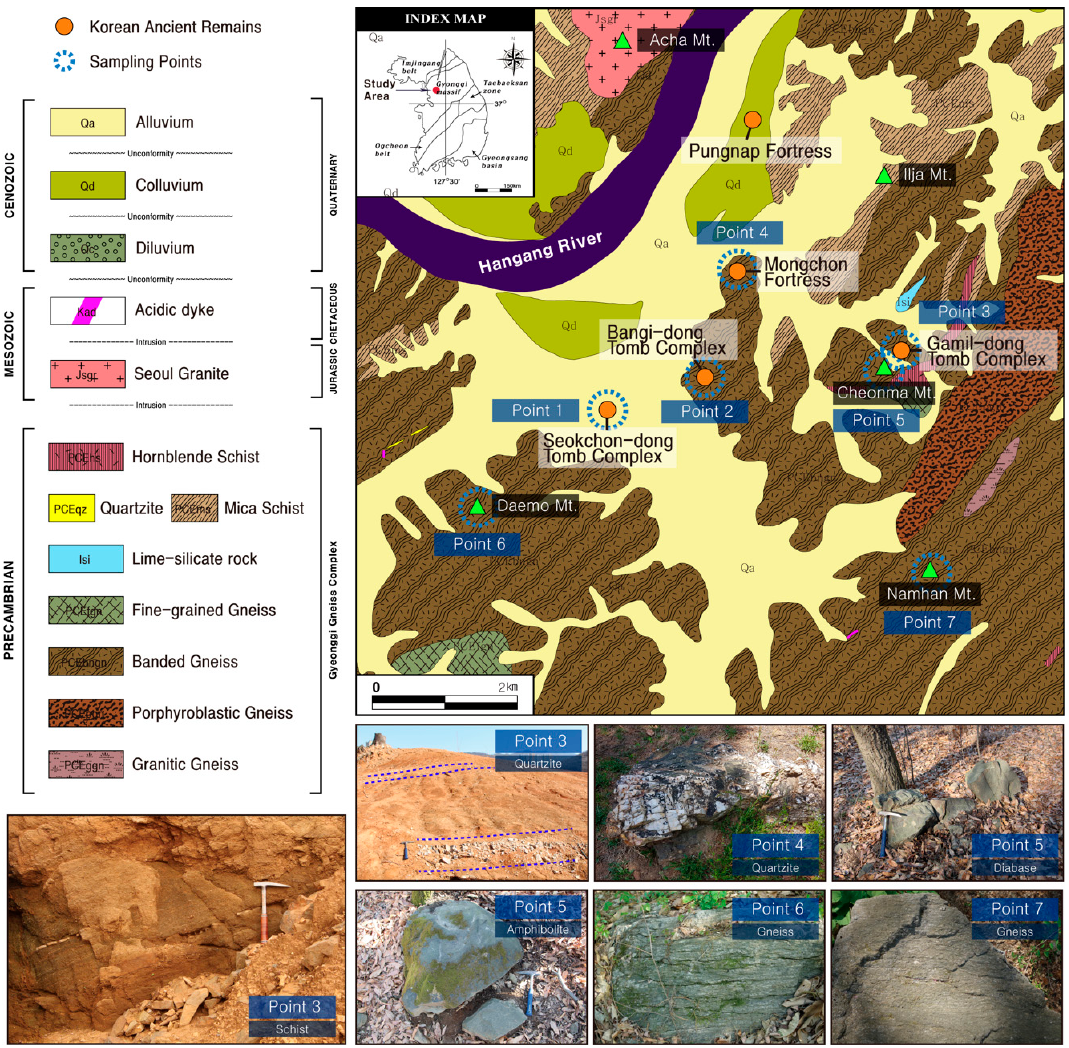
Figure 1. Geologic map and state of outcrop in each sampling points (point 1 to 7) around ancient Korean tombs and other remains in Seoul.